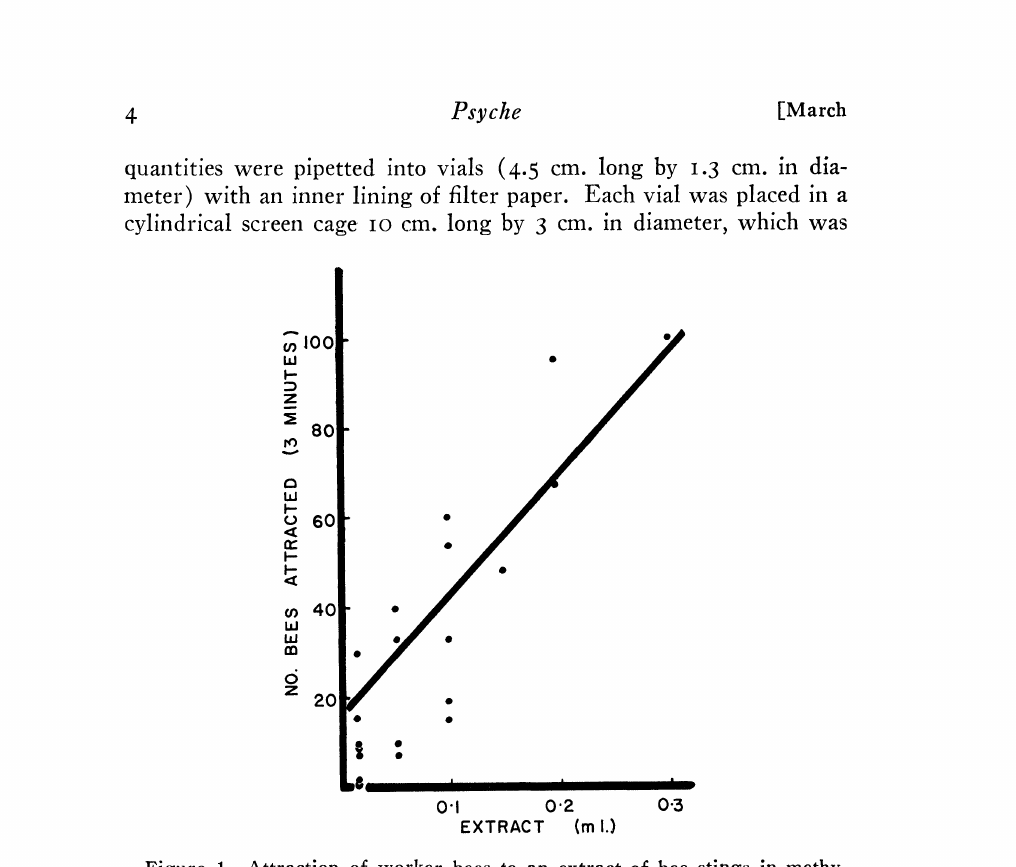
Figure I. Attraction of worker bees to an extract of bee stings in methy- lene chloride. The extract was pipetted onto filter paper and introduced in screen cages laid over the combs of a colony. Bees attracted to each cage were collected and counted. open at one end. The cages were laid in groups of four across the top bars o an open colony, immediately enclosed by an empty hive body and cover, and let in this dark chamber for 3 minutes. Each was then carefully transferred with the adhering bees into a closed con- tainer. The bees thus collected were anesthetized and counted (Fig. I). Although the data show considerable variation, there was a positive correlation between the quantity of extract per vial and the number o bees